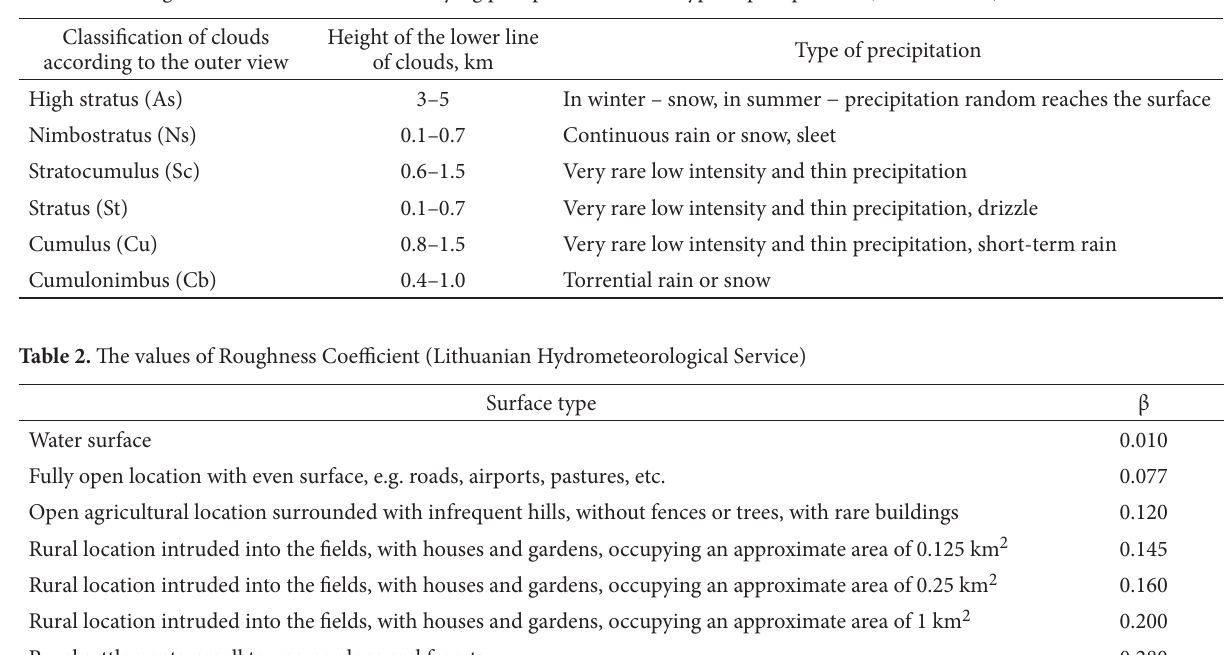
Table 1. The height of movement of clouds carrying precipitation and the type of precipitation (Rimkus 2005) Classification of clouds Height of the lower line according to the outer view of clouds, km